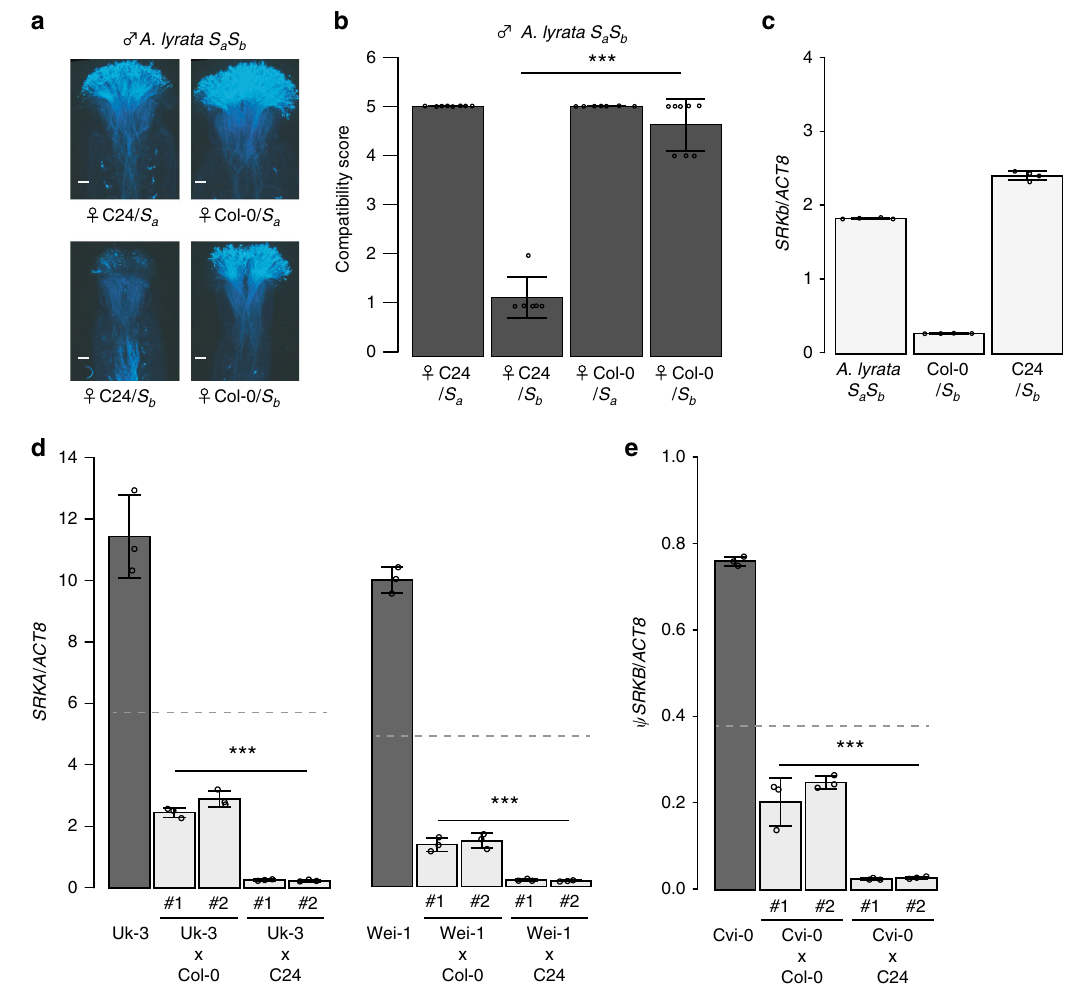
Fig. 3. SRKIR Col-0 and SRKIR C24 may suppress multiple endogenous SRK alleles. a Representative fl uorescent images of aniline blue-stained pistils at stage 14 of A. thaliana – lyrata inter-species hybrids with different genotypes 3 h after pollination. C24/ S a and C24/ S b are individuals obtained from the cross A. lyrata S a S b × C24 that inherited the S a and S b alleles, respectively. Similarly, Col-0/ S a and Col-0/ S b are A. lyrata S a S b x Col-0 hybrids that inherited the S a and S b alleles, respectively. Pollen from an A. lyrata S a S b individual was used for the pollination test. Scale bars = 100 µ m. b Summary of pollination tests. A statistically signi fi cant difference between C24/ S b and Col-0/ S b (*** p < 0.005) was detected using Dunnett ’ s test, with the exact p -value being 0.00e + 00. Error bars indicate standard deviations. Number of pistils pollinated (from left to right): n = 8, n = 6, n = 7, n = 8. c Relative mRNA accumulation levels of SRKb compared to the A. lyrata ACTIN8 ortholog in stigmatic tissues of the indicated lines. Error bars indicate standard deviations from independent RNA extraction trials ( n = 4). d , e Relative mRNA accumulation levels of the SRK genes compared to ACT8 in stigmatic tissues of the indicated lines. For each hybrid cross, two individuals (#1 and #2) were tested. In c – e error bars indicate standard deviations from independent RNA extraction trials ( n = 3). The broken lines indicate the expected mRNA accumulation level of the SRK genes in the hybrids compared to that of the parents (theoretically one-half). Dunnett ’ s tests were used to fi nd signi fi cant differences (*** p < 0.005) compared to the expected mRNA level. d The exact p -values from left to right: 5.02e − 13, 2.22e − 16, 0.00e + 00, 0.00e + 00, 1.17e − 06, 1.05e − 04, 7.71e − 12, and 8.88e − 16. e The exact p values from left to right; 1.63e − 05, 9.15e − 05, 2.00e − 15, and 7.77e −